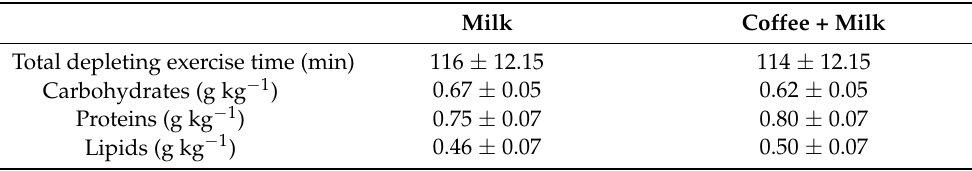
Figure 3. Flow diagram of the progress through the phases of the study. Table 1. Exercise time and macronutrient intake in the evening meal for glycogen depletion in experimental